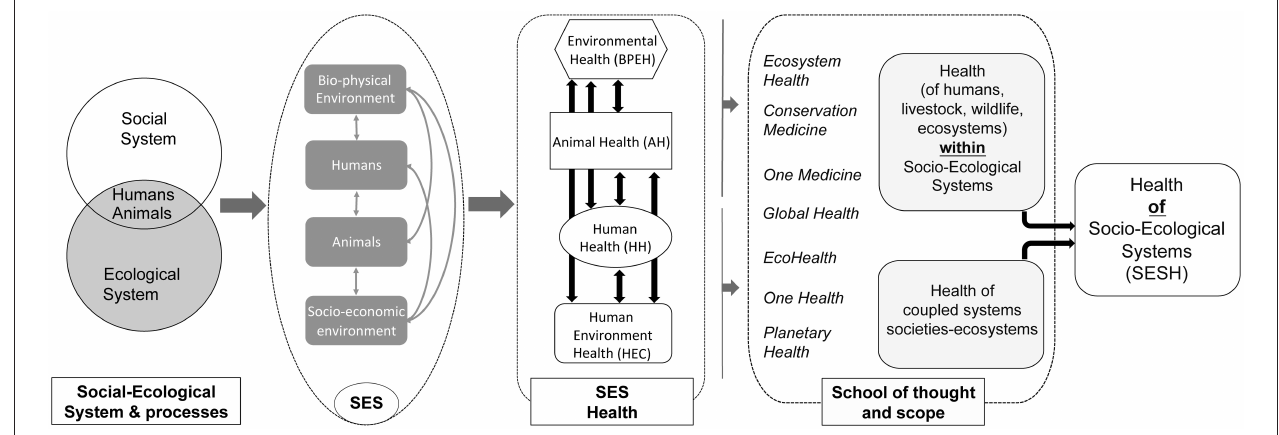
FIGURE 1 | Expanding the concept of social-ecological systems to Social-Ecological System Health. Conceptual model connecting a social-ecological system template to the health of its components and the health of the whole social-ecological system (left and central parts of the graph); main integrated approaches associated with the specific health components and their interactions [definitions as in ( 12, 34); right part of the graph]. BPEH, bio-physical environment health; AH, Animal Health; HH, Human Health; HEC, Human Environment Health; SESH, Social-Ecological System